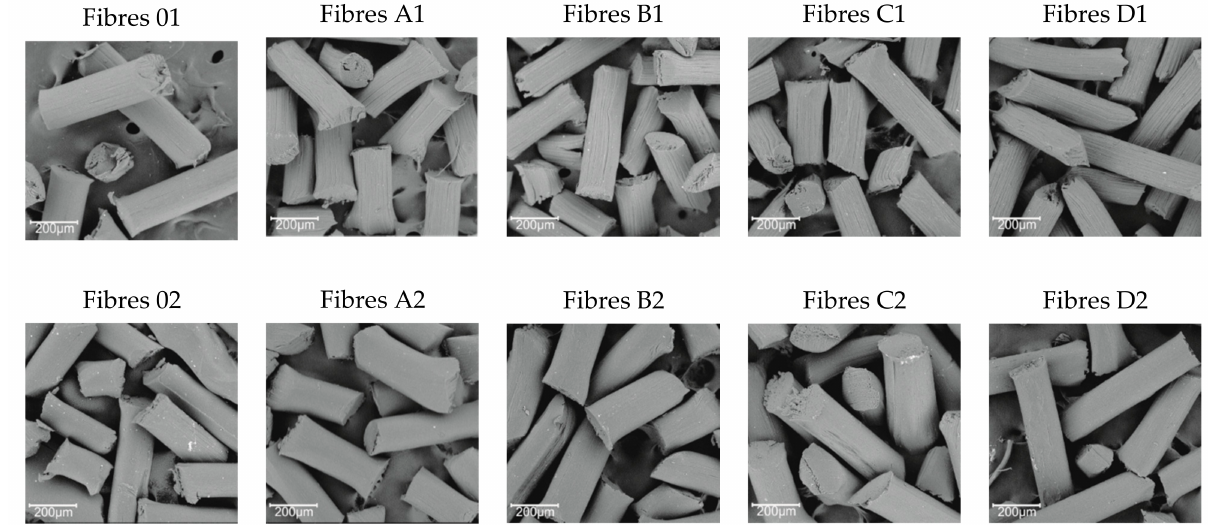
Figure 4. SEM (scanning electron microscopy) images for surfaces fibres that were coagulated in water (1) and methanol (2) (300 × magnification).